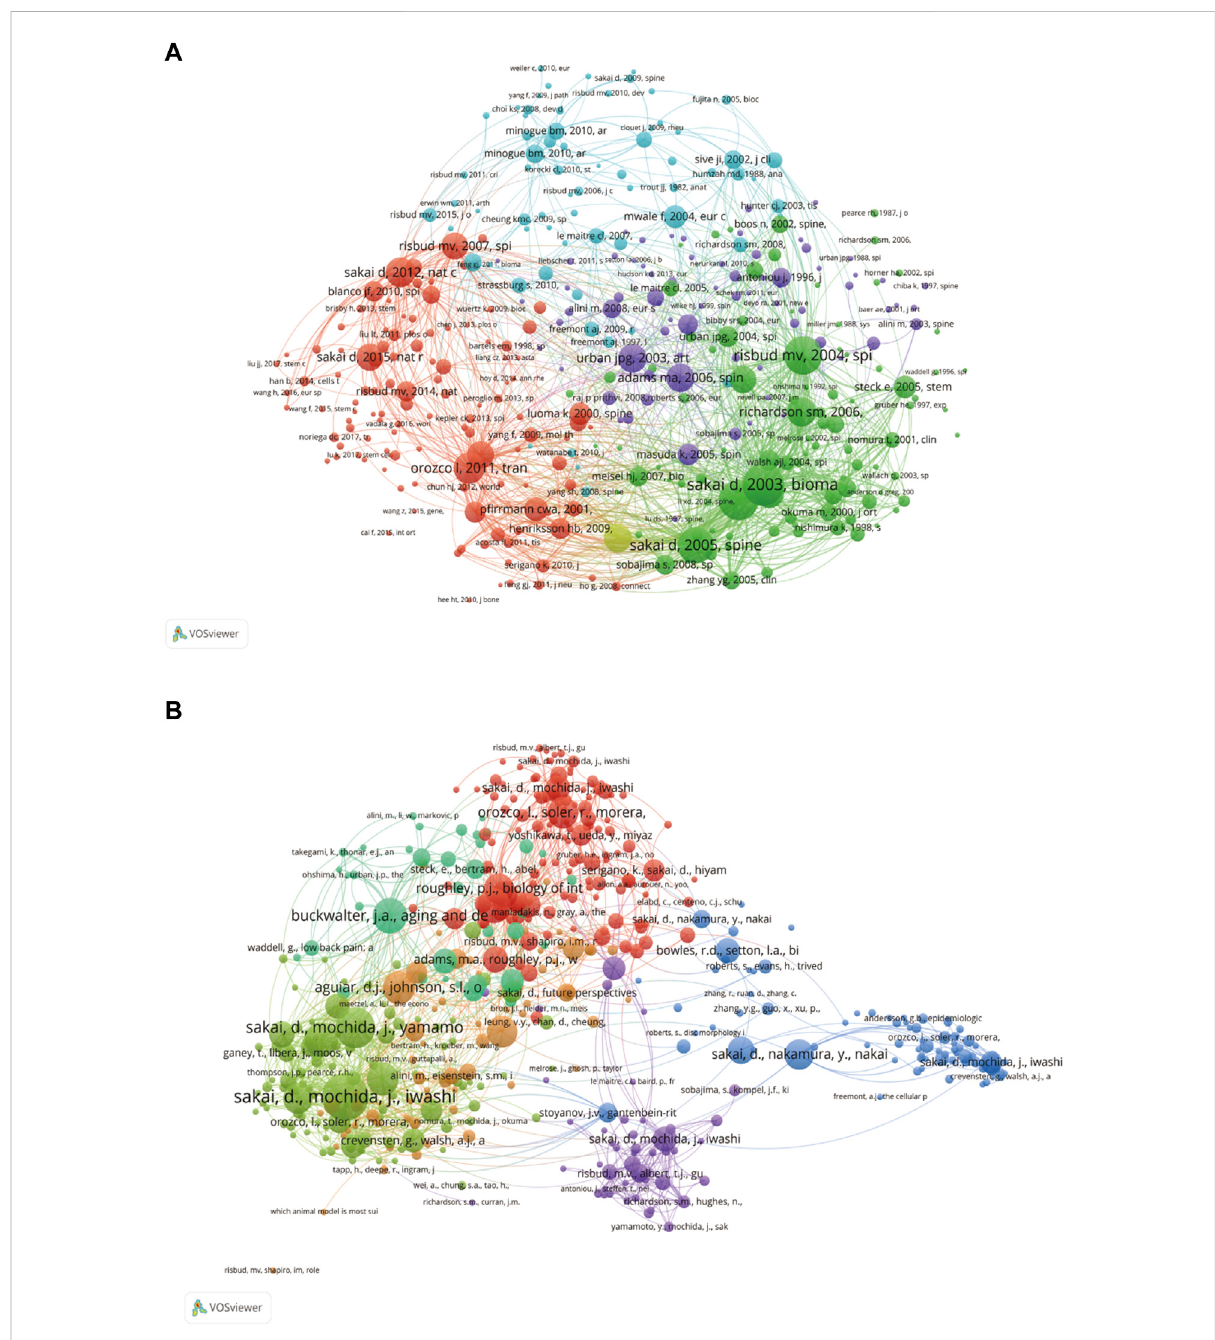
FIGURE 8 The co-citations network graph in WOSCC (A) and Scopus (B) . In WOSCC, co-citations formed 5 clusters and 6 clusters were formed from Scopus. Different colours represented different clusters. The size of a node represented how many citations the document has received, the higher the number of citations the larger the node. If two nodes were connected, they were connected by lines, and the more nodes connected, the stronger the